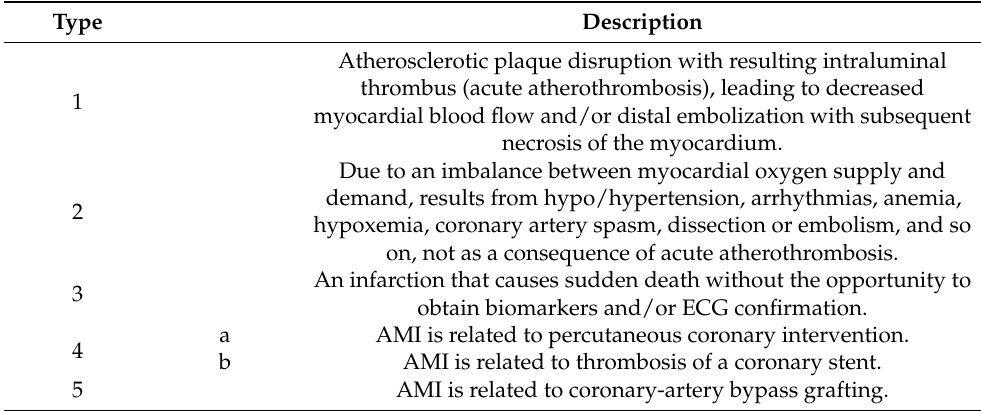
Table 1. Types of AMI [17,19]. ECG: 12-lead